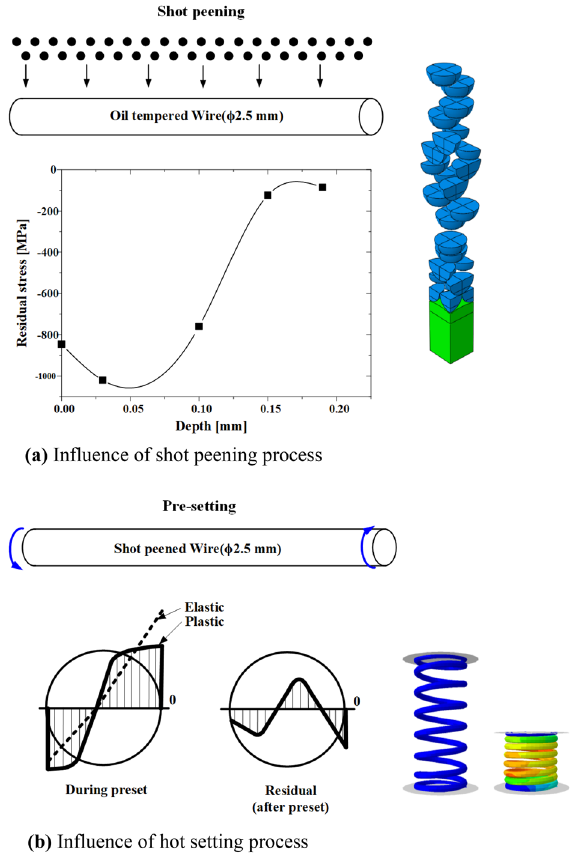
Figure 22. Application of shot peening and torsion to the OT